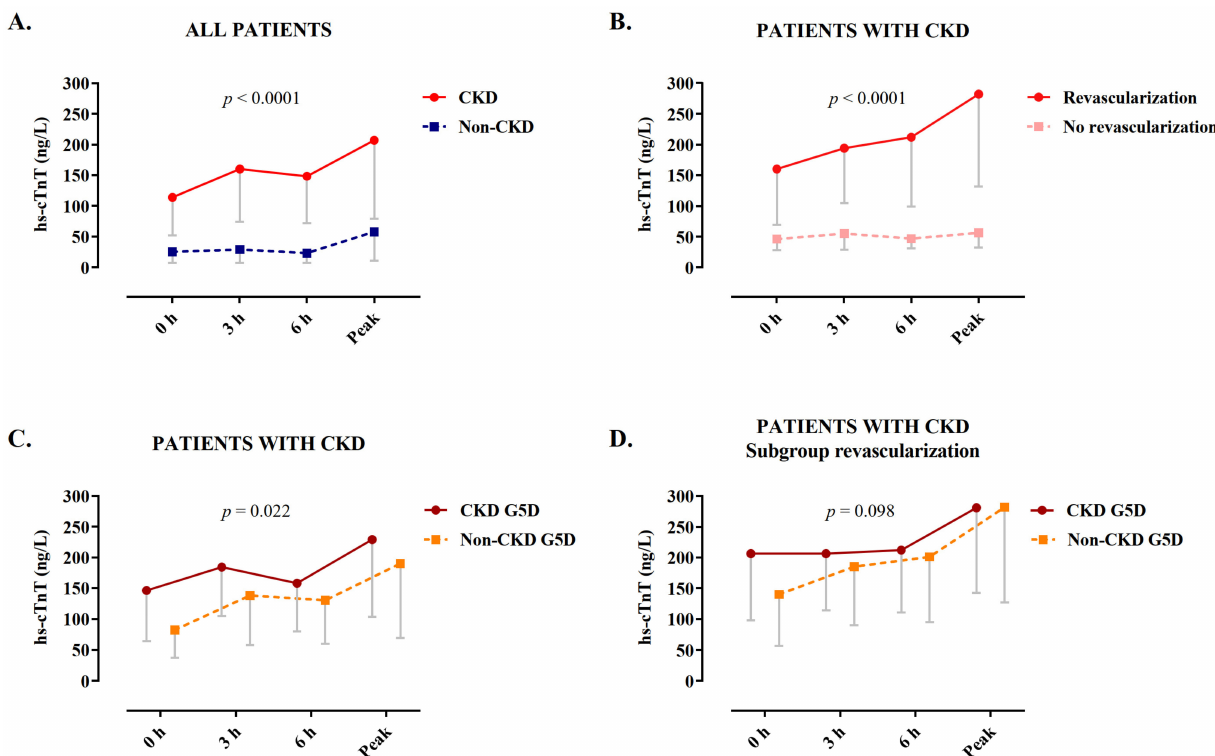
Figure 2. Levels of hs-cTnT at serial sampling. ( A ) Patients with normal renal function versus patients with severe CKD. ( B – D ) Among patients with severe CKD: ( B ) according to revascularization and conservative treatment, ( C ) in presence or absence of CKD G5D, and ( D ) in the subgroup of patients undergoing revascularization, in those with versus without